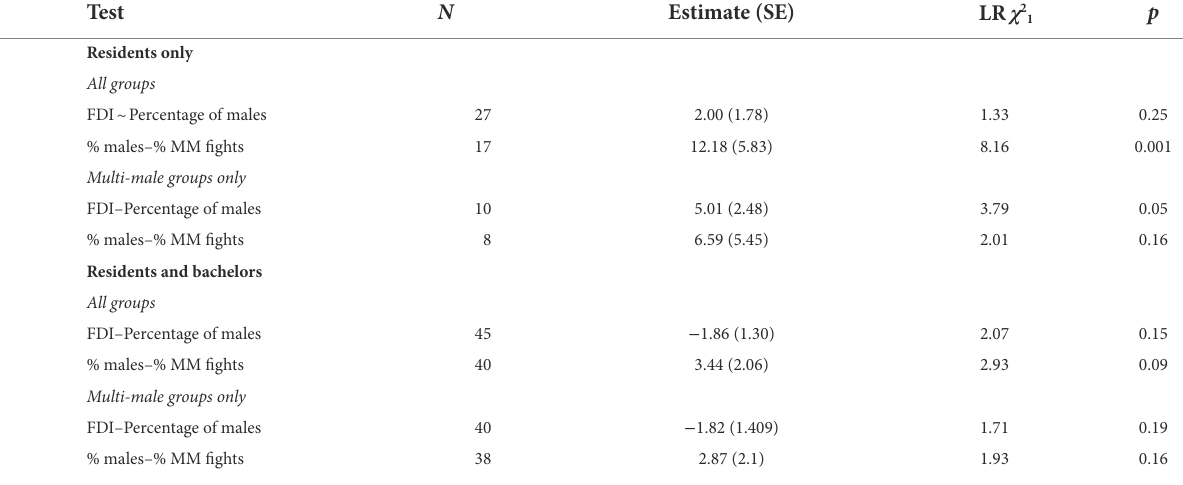
TABLE 3 Statistical results (GLMM) for the relationship between the percentage of males (predictor) and either the Female Dominance Index (FDI) or the percentage of male–male fights out of all fights involving males with other adult hyraxes of either sex (dependent